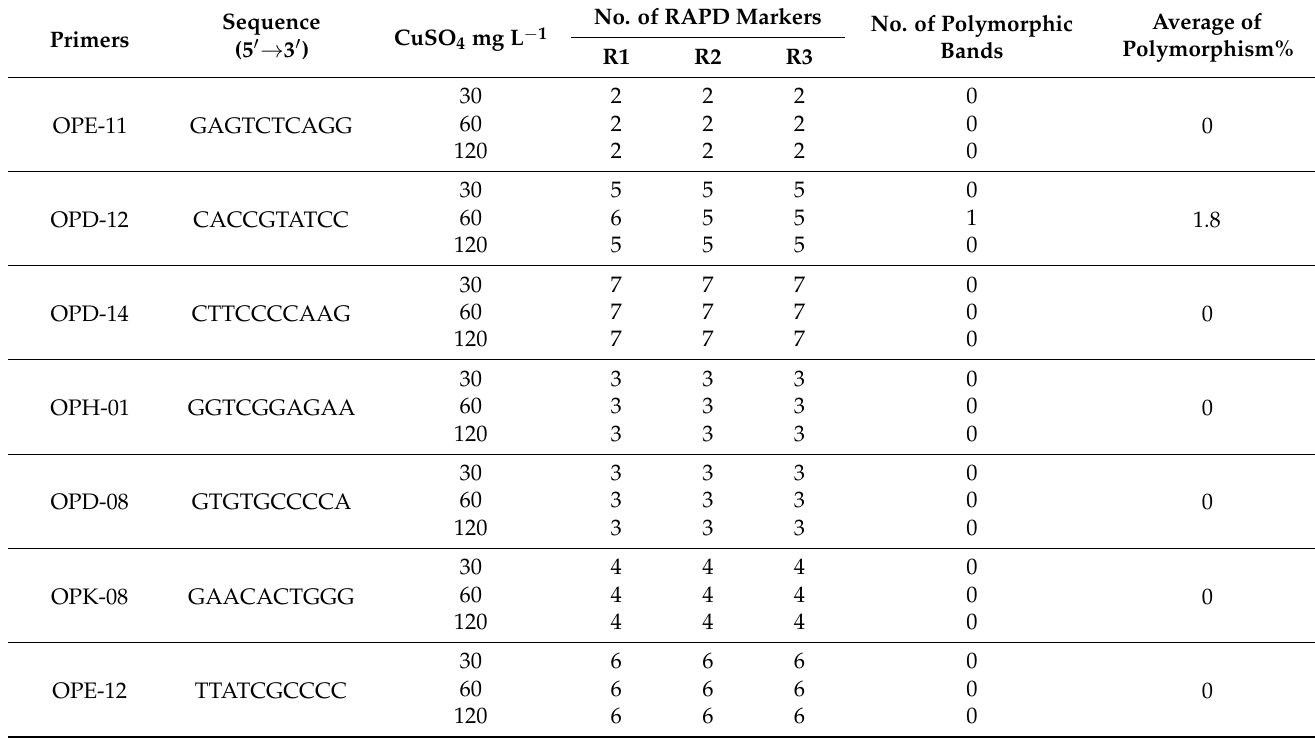
Table 6. Sequences of the selected primers used in RAPD analysis and the number of generated RAPD markers and average polymorphism